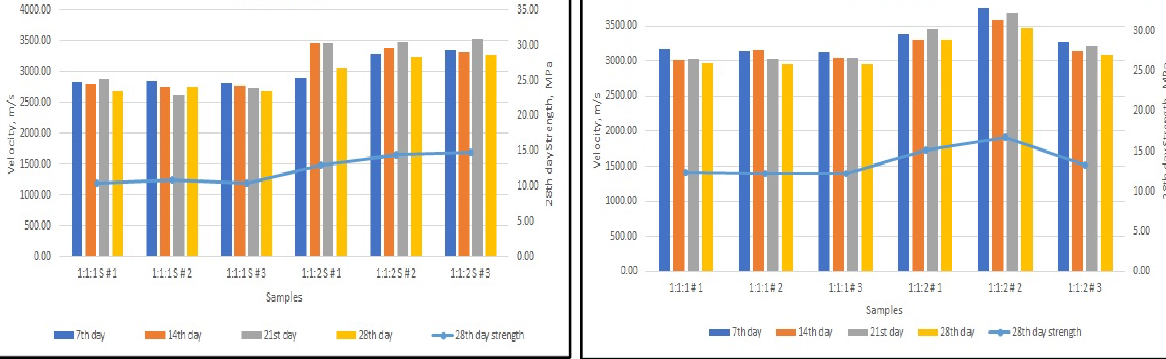
Figure 2. Strength Development of (a) Geopolymer Concrete without Superplasticizer (b) Geopolymer Concrete with Superplasticizer.